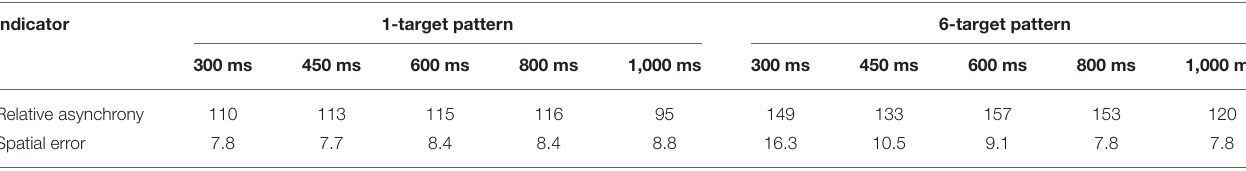
TABLE 1 | Synchronization and spatial indicators for Study 1.